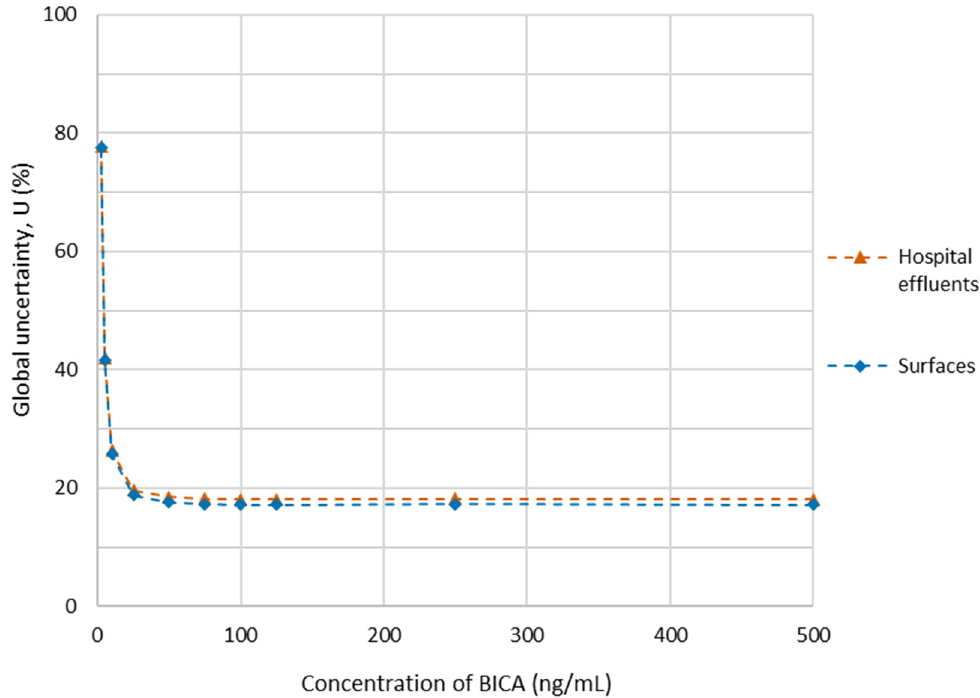
Figure 2. Global uncertainty of the analytical methodology for bicalutamide quantification in hospital effluents and surfaces by HPLC–FLD. Dashed lines are merely illustrative of the data trend. 50 ng/mL corresponds to 100 pg/cm 2 in the case of surface samples.